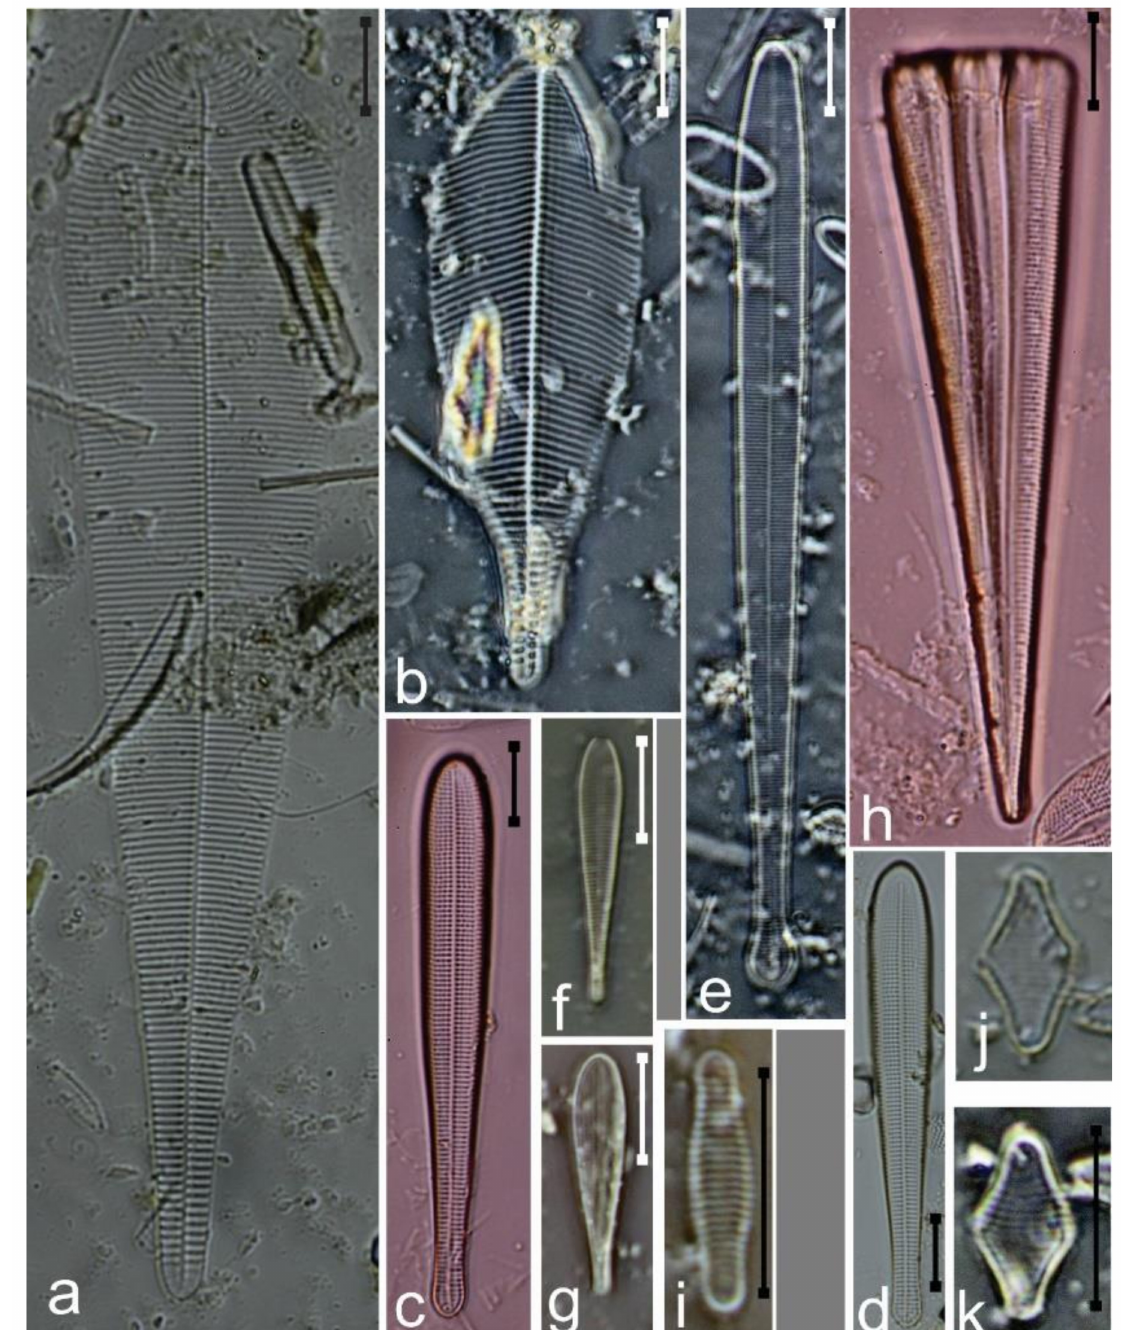
Figure 19. ( a , b ) Licmophora ehrenbergii ; ( c , d ) L. paradoxa ; ( e ) L. pfannkucheae ; ( f , g ) L. gracilis var. anglica ; ( h ) L. abbreviata frustule in girdle view; ( i – k ) Hyalosira tropicalis . Scale bar = 10 µ